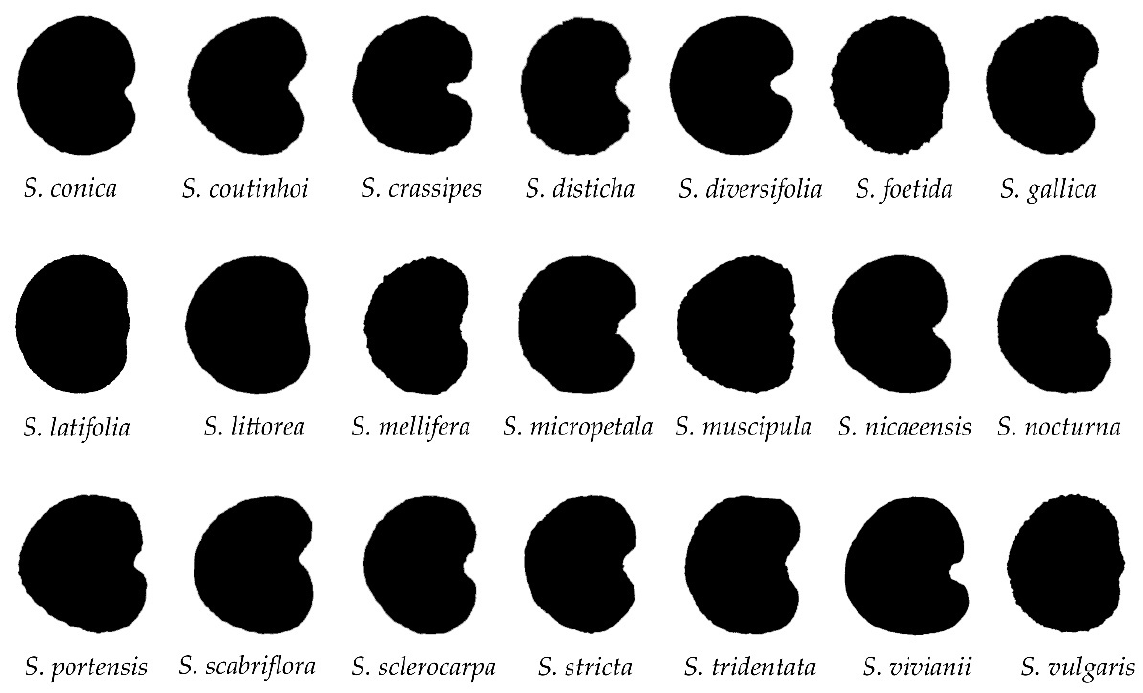
Figure 2. Average silhouettes obtained for the lateral views of the seed in the 21 species analyzed. Table 2. Mean values of the area (A), perimeter (P), length of the major axis (L), length of the minor axis (W), aspect ratio (AR), circularity (C), and roundness (R) in the lateral view of seeds of Silene . Values of A are given in mm 2 ; P, L and W, in mm. Superscript letters indicate the results of Scheffé test: the mean values marked with the same letter in each column do not differ significantly at p < 0.05. N is the number of seeds analyzed. S.